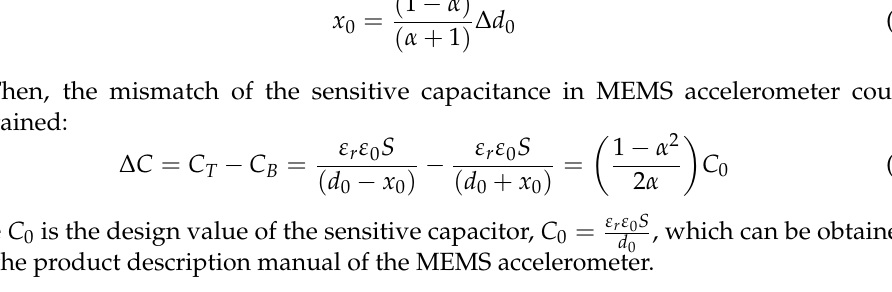
Table 1. The characteristic parameters of the experimental